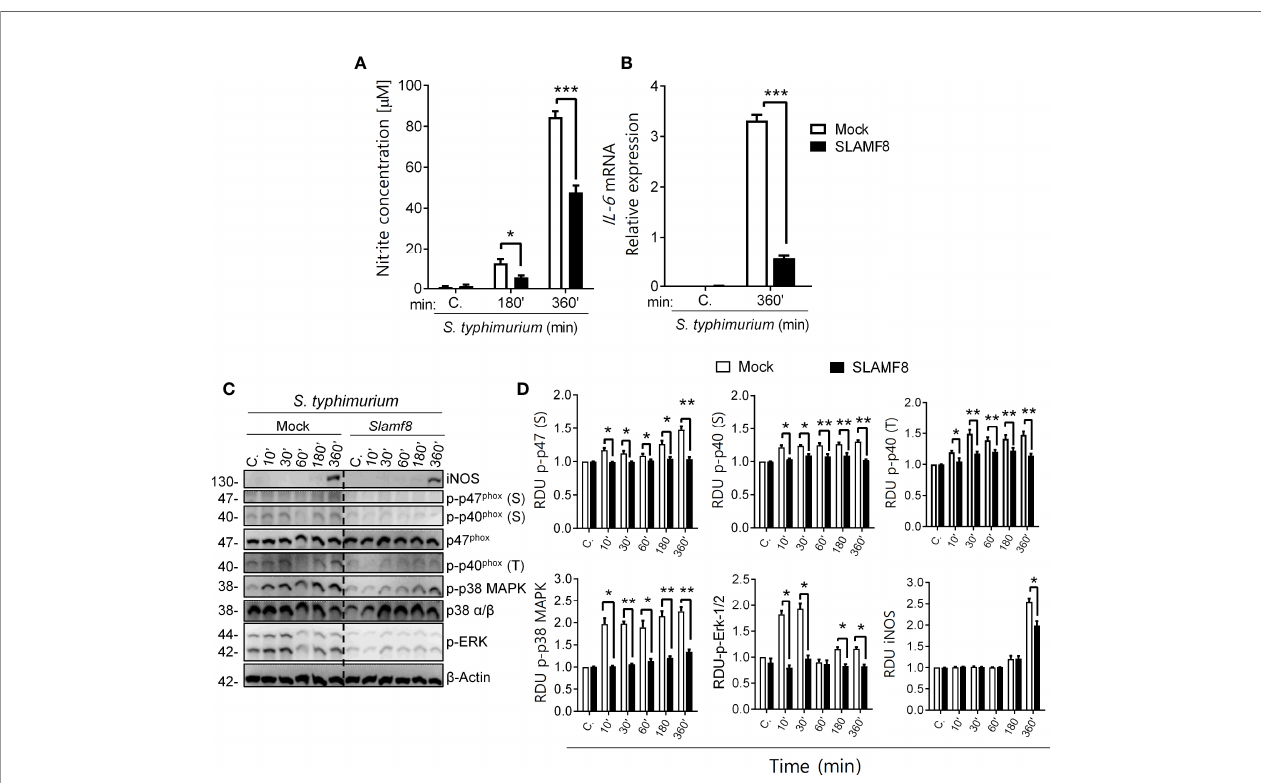
FIGURE 9 | Study of NOS type II induction, NOX2 activation through phosphorylation analysis of p47 phox , p40 phox , and p38/ERK MAPK in SLAMF8 or mock-transfected RAW264.7 Mø. Determination of NO production and IL-6 mRNA expression. Stable clones isolated from RAW264.7 Mø transfected with cDNA encoding Myc-tagged Slamf8 or mock-transfected cells were infected with S. typhimurium (MOI 10) at different chase times. The protein samples were subjected to Western blot analysis and results of one out of three independent experiments are shown. (A) Analysis of nitrite production in Slamf8 or mock-transfected RAW264.7 Mø. Histogram shows nitrite concentration [ m M], as determined by the Griess reaction, in Mø infected with S. typhimurium at different chase times. Values indicate mean ± SEM. (B) Relative expression of il-6 mRNA in Myc-tagged Slamf8 or mock-transfected RAW264.7 cells infected with S. typhimurium (MOI10) as analyzed by quantitative RT-PCR. (C) Representative Western blots of indicated phosphorylated proteins and levels of iNOS/NOS type II are shown. (D) Relative expression of phosphorylated proteins as indicated in (C) Phosphorylation levels were normalized to appropriate loading control and are graphically represented. Gene expression was normalized to basal expression levels of mock- transfected RAW264.7 cells. Data were analyzed by the 2 − DD Ct method, and HPRT1 was used as the reference gene. * p < 0.05; ** p < 0.01; *** p < 0.001. C, control; MOI, multiplicity of infection; RDU, relative densitometry units; S, Serine; T,